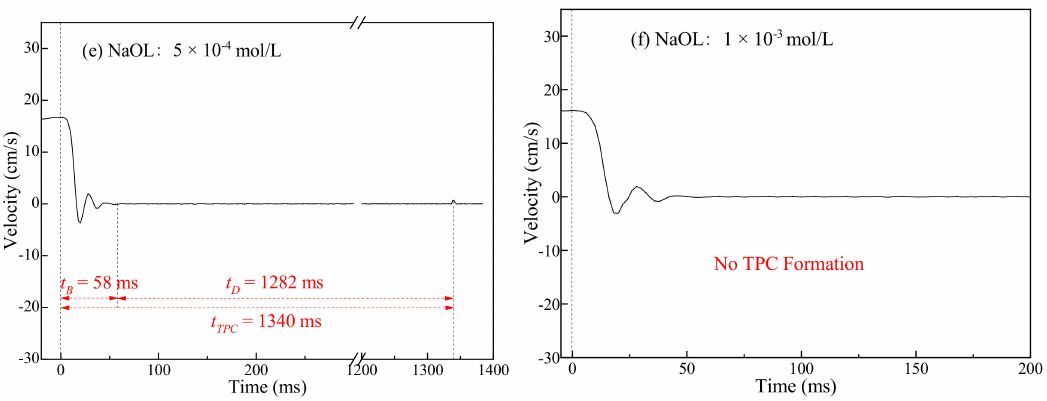
Figure 13. Bubble velocity variation during collision-rebound process with talc surface in NaOL solution with different concentrations. ( a ) 5 × 10 − 6 mol/L; ( b ) 1 × 10 − 5 mol/L; ( c ) 5 × 10 − 5 mol/L; ( d ) 1 × 10 − 4 mol/L; ( e ) 5 × 10 − 4 mol/L; ( f ) 1 × 10 − 3 mol/L.3.2.3. Mechanism Analysis of TPC Formation.